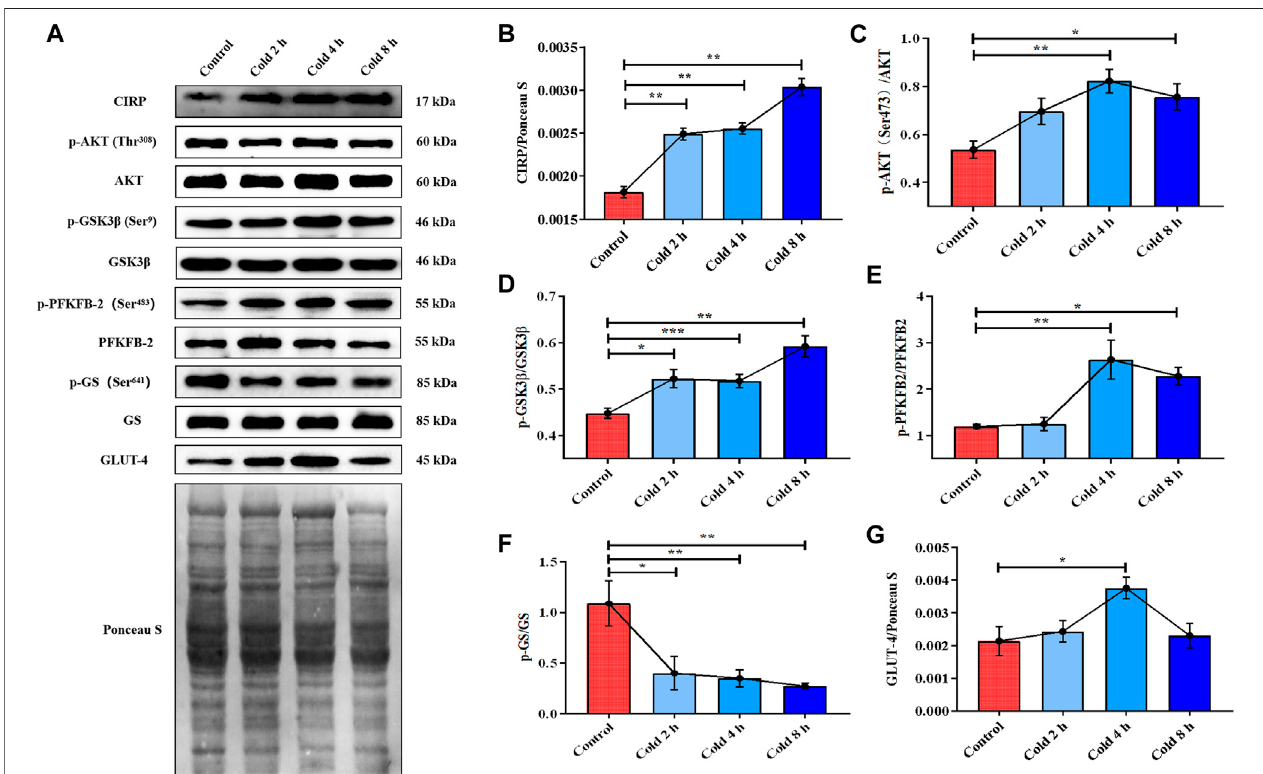
FIGURE 2 | Acute cold exposure up-regulated the expression of CIRP, activated AKT and enhanced glucose metabolism in skeletal muscle of micehanges of glucose metabolism induced by acute cold exposure in mice. (A) Western blotting results of glucose metabolism related proteins in mouse skeletal muscle after acute coldexposure.TheproteinexpressionlevelsandphosphorylationstatusofCIRP (B) ,AKT (C) ,GSK3 β (D) ,PFKFB2 (E) ,GS (F) andGLUT-4 (G) intheskeletalmusclesof mice. The data are presented as the mean ± SEM (n (cid:1) 8). Statistically signi fi cant differences are indicated; * p < 0.05, ** p < 0.01. CIRP, cold inducible RNA-binding protein; AKT, protein kinase B; GSK3 β , glycogen synthase kinase-3 β ; PFKFB2, 6-phosphofructo-2-kinase/fructose-2,6- biphosphatase 2; GS, glycogen synthase; GLUT-4, glucose